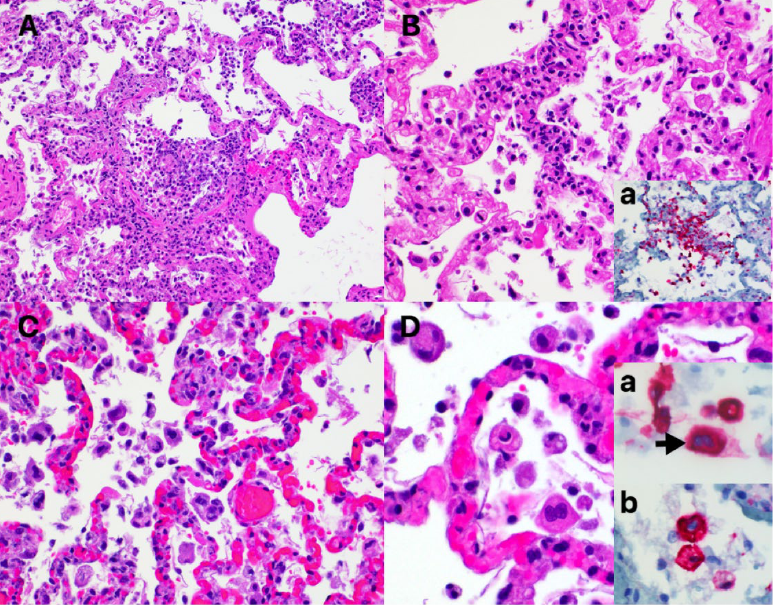
Figure 2. Histological changes in the lung of the SARS-CoV-2 infected cat. ( A ) Necrotizing bronchiolitis and diffuse alveolar damage (DAD), with a partially occluded bronchiole with necrotic cellular debris and inflammatory cells. Adjacent alveolar spaces contain increased cellularity, mild edema and fibrin strands and the interstitium is expanded with numerus inflammatory cells. Hematoxylin and eosin. 20× magnification. ( B ) Capilaritis. Alveolar septa are infiltrated with neutrophils and macrophages. A fibrin thrombus is identified adjacent to the area of inflammation (arrow). Hematoxylin and eosin. Inset a. Iba-1 immunohistochemistry of an area of capillaritis, highlighting the presence of numerous macrophages. Mayer’s hematoxylin counterstain. 40× magnification. ( C ) Alveolar spaces containing increased numbers of mononuclear cells and necrotic cellular debris. The alveolar septa are markedly congested with increased numbers of neutrophils and macrophages. Hematoxylin and eosin. 20× magnification. ( D ) Reactive atypia. Cells present in alveolar spaces, with abundant eosinophilic cytoplasm and moderately enlarged nucleus. Hematoxylin and eosin. 40X magnification. Inset a. Pancytokeratin immunohistochemistry of alveolar cells, indicative of epithelial cells. One binucleated cell is noted (syncytium, arrow). Mayer’s hematoxylin counterstain. Inset b. Iba-1 immunohistochemistry of alveolar cells, indicative of macrophages. Mayer’s hematoxylin counterstain. 40× magnification.